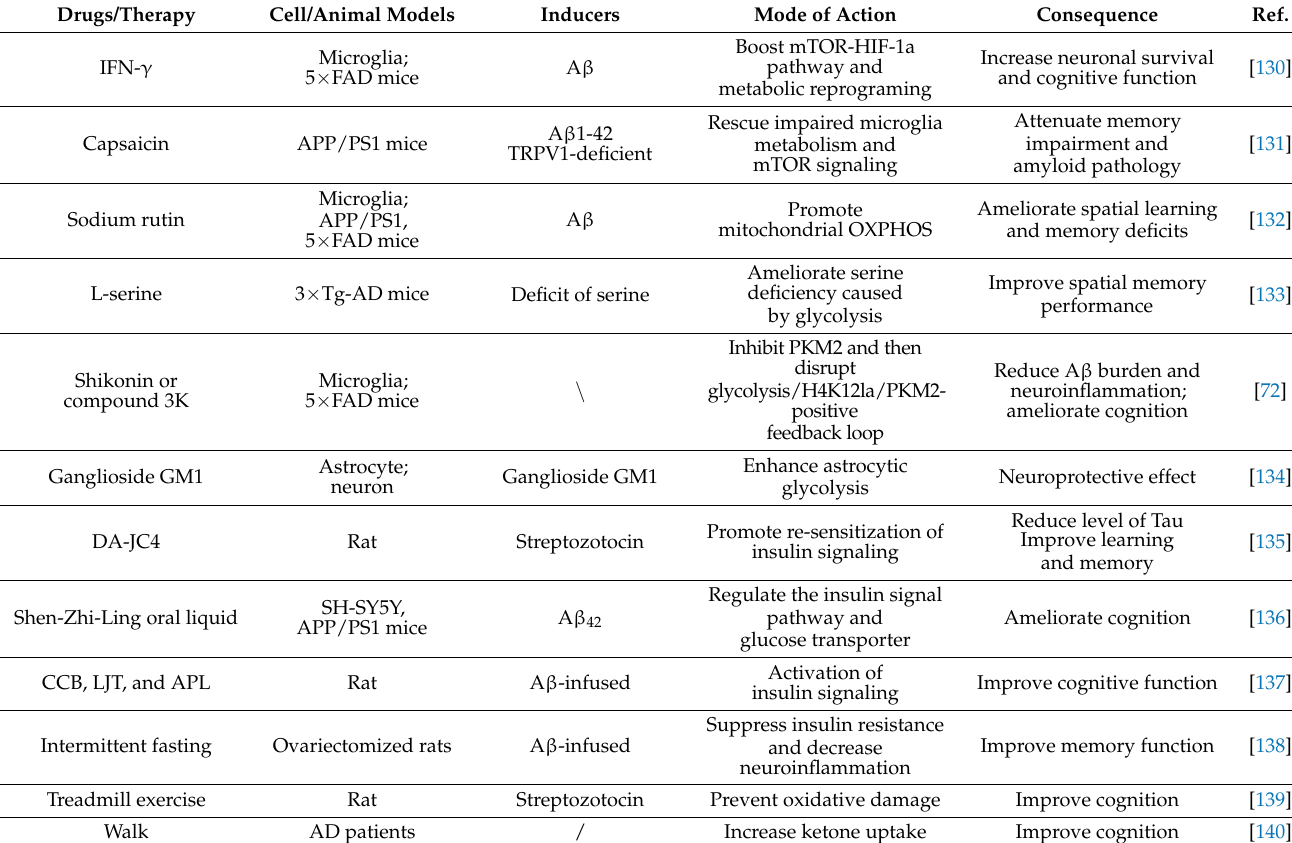
Table 1. Metabolic reprogramming of glial cells (microglia and astrocytes) in